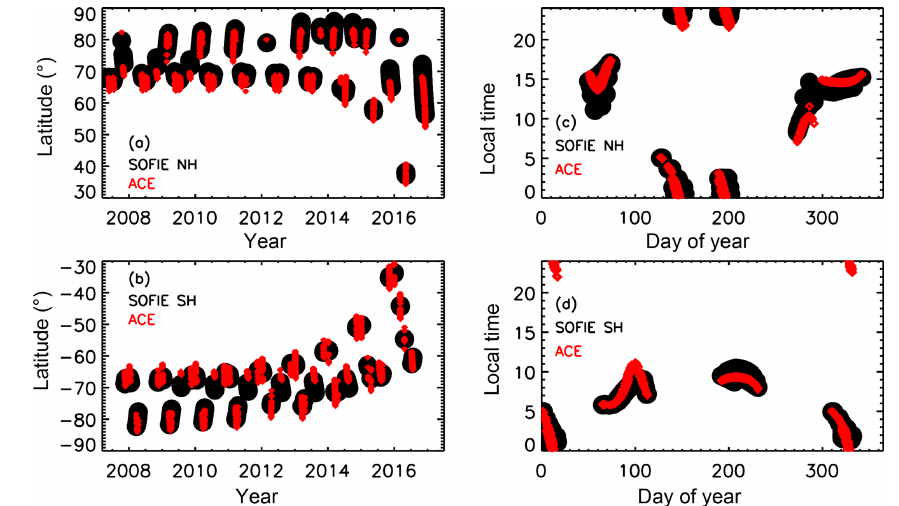
Figure 5. Summary of SOFIE–ACE coincidences. Measurement latitude vs. year in the (a) NH (SOFIE sunrise; local sunset) and (b) SH (SOFIE sunset; local sunrise). Measurement LT versus day of year in the (c) NH and (d) SH. There were 2968 coincidences in the NH with average separations of 0.7h, 1.7 ◦ latitude, and 8.0 ◦ longitude. There were 2473 coincidences in the SH with average separations of 0.6h, 2.3 ◦ latitude, and 8.0 ◦ longitude.